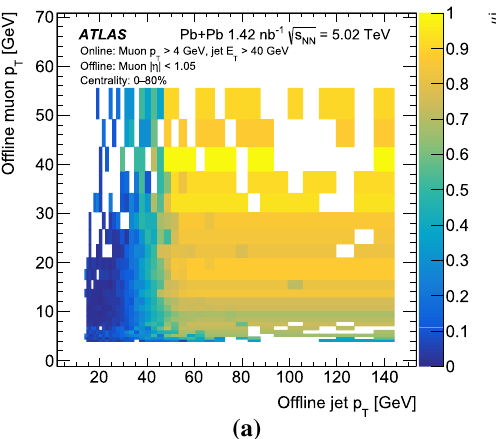
Fig. 17 The two-dimensional absolute trigger efficiency, ε μ j , as defined in Eq. (2), of the muon-jet trigger that requires a muon with p T > 4GeV and a jet with E T > 40GeV, as a function of the offline muon p T and jet p T . The measurements are performed inclu-